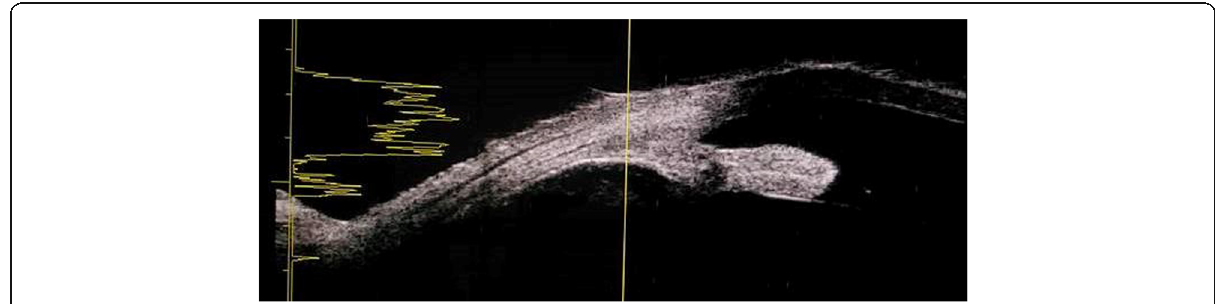
Fig. 6 Day 15 post-laser UBM at ~8 o ’ clock documents ciliary body swelling, cystic morphology, and echoes occupying the space between the iris and